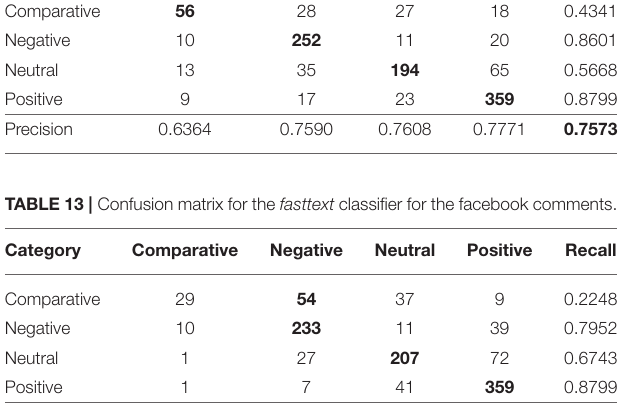
TABLE 12 | Confusion matrix for the facebook comments in the best combination, i.e., BoW feature set - Stochastic Gradient Descent classifier. Category